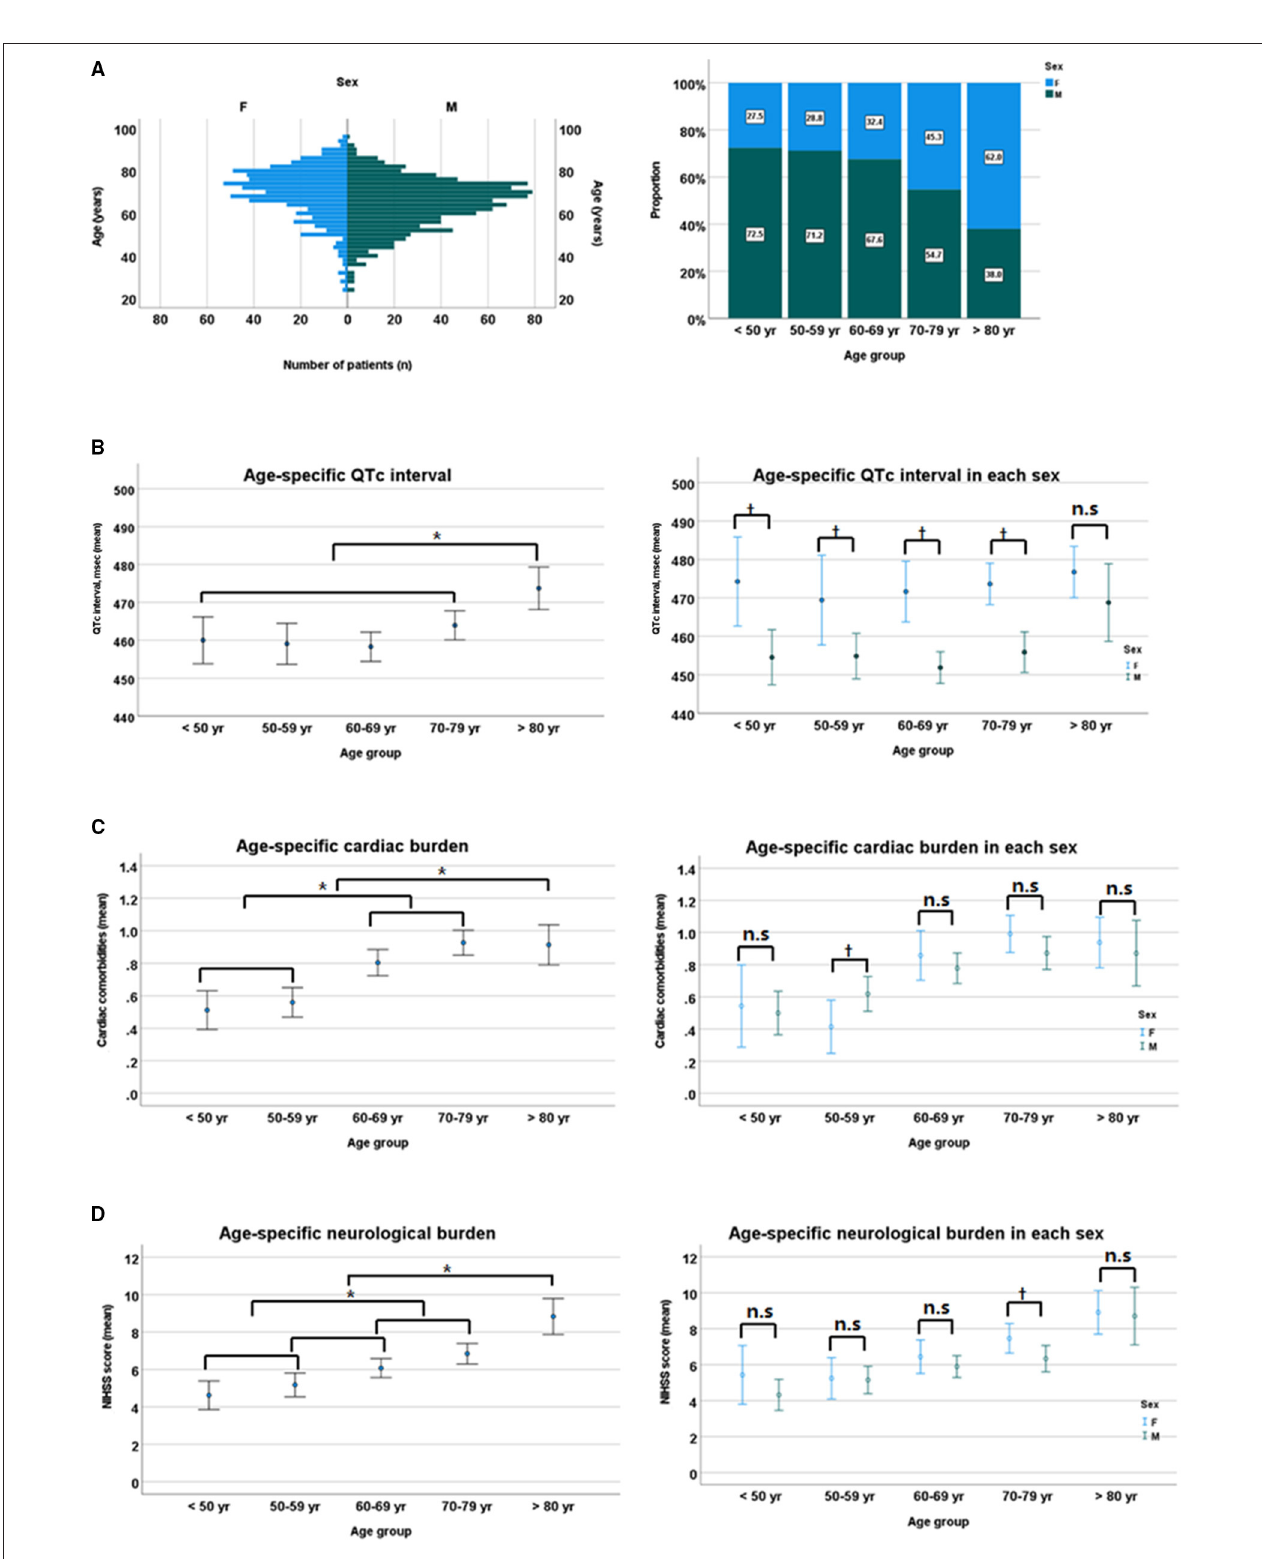
FIGURE 4 | Sex-specific age distribution (A) , sex differences in QTc intervals (B) , cardiac burden (C) , and neurological burden (D) . NIHSS, National Institutes of Health Stroke Scale. * p < 0.05 by ANOVA with Duncan post-hoc test according to age group. † p < 0.05 by Student t -test between sexes in each age group. n.s, non